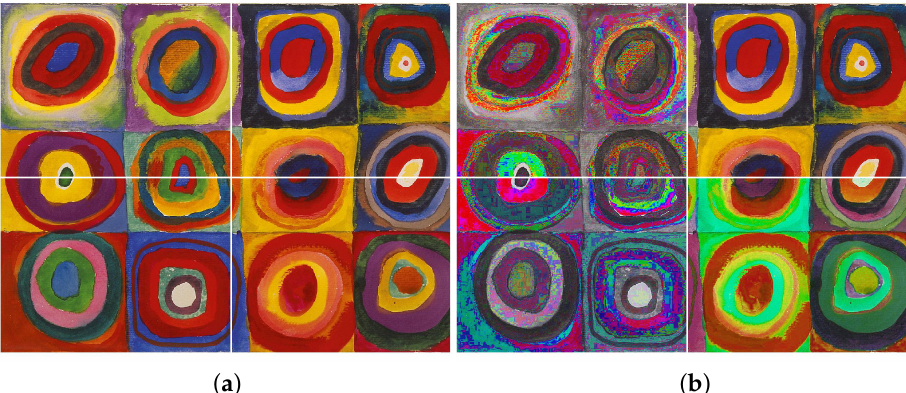
Figure 1. ( a ) Vasily Kandinsky (1866–1944): Farbstudie-Quadrate mit konzentrischen Ringen (Color study. Squares with concentric rings), 1913. ( b ) Color symmetry using a color permutation associated with the symmetry group of the